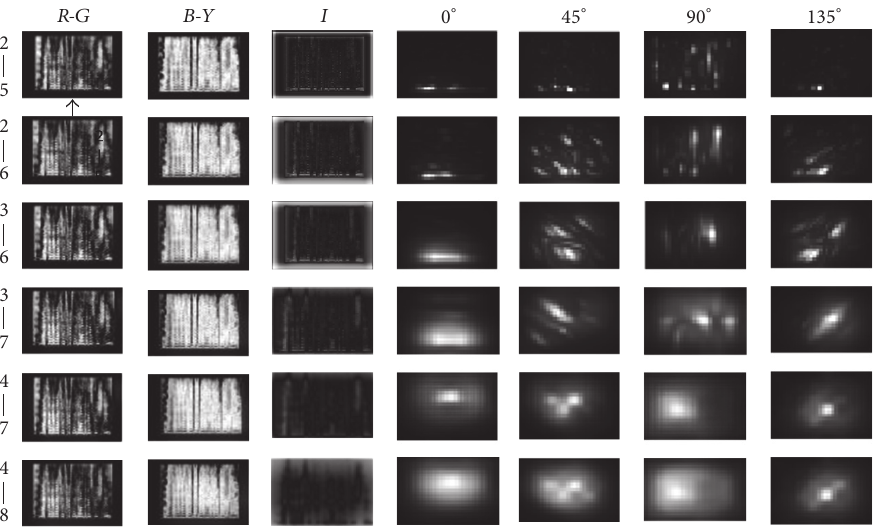
Figure 3: Gist feature images based on